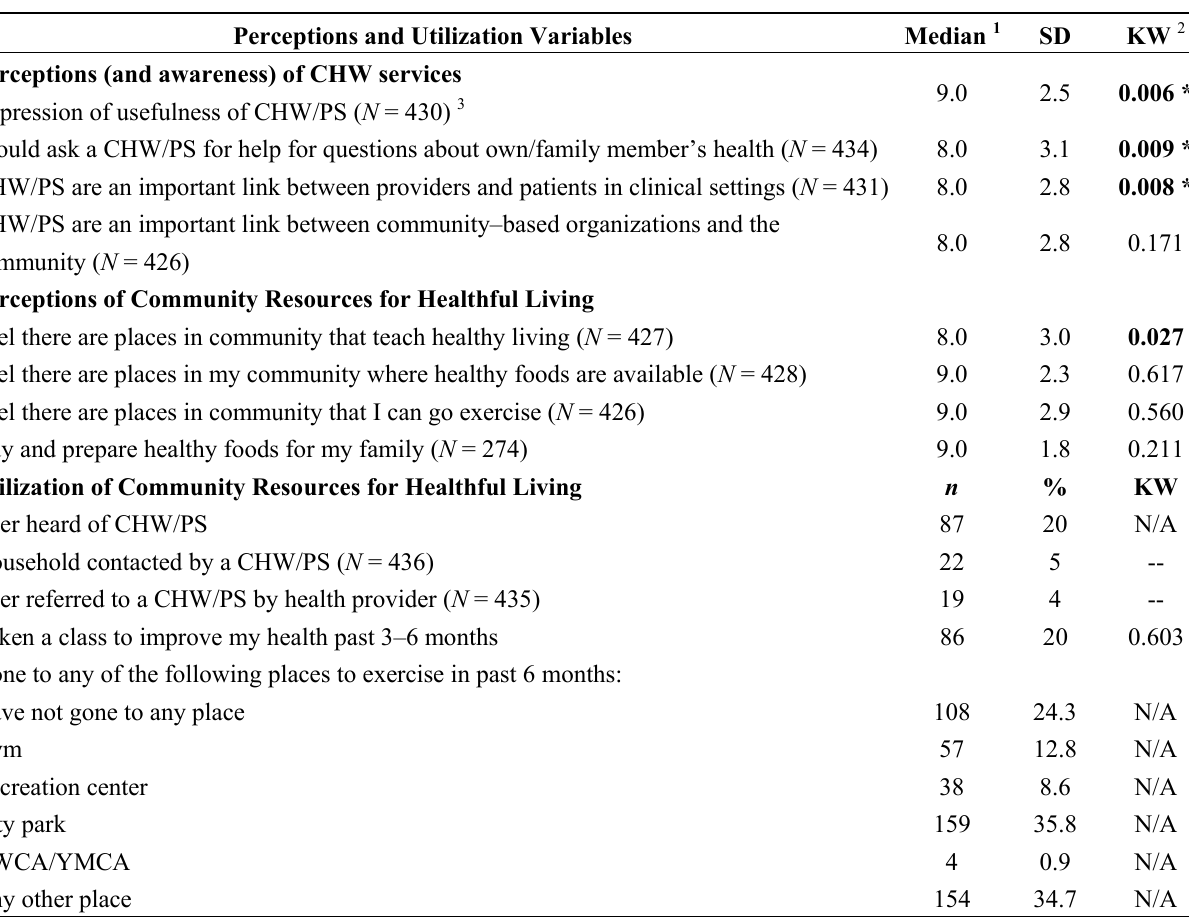
Table 2. Perceptions and Utilization of Community Resources for Healthful